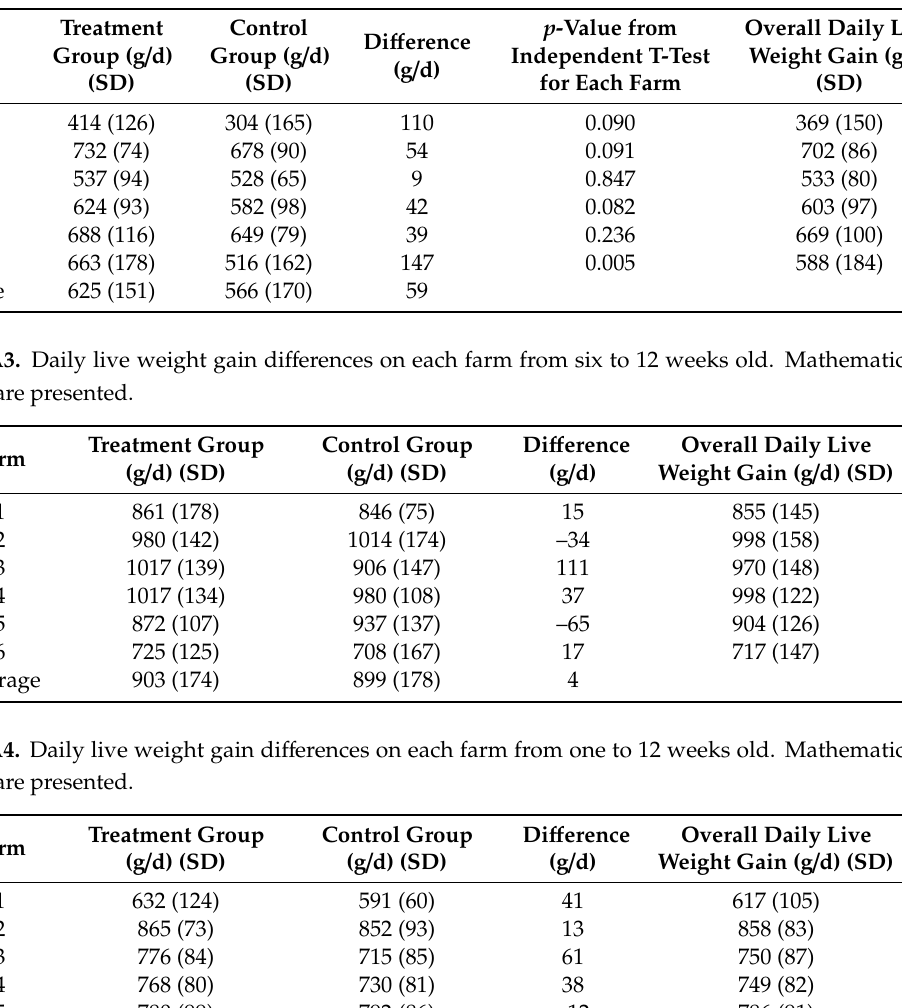
Table A2. Daily live weight gain di ff erences on each farm from one to six weeks old. Mathematical means are presented.